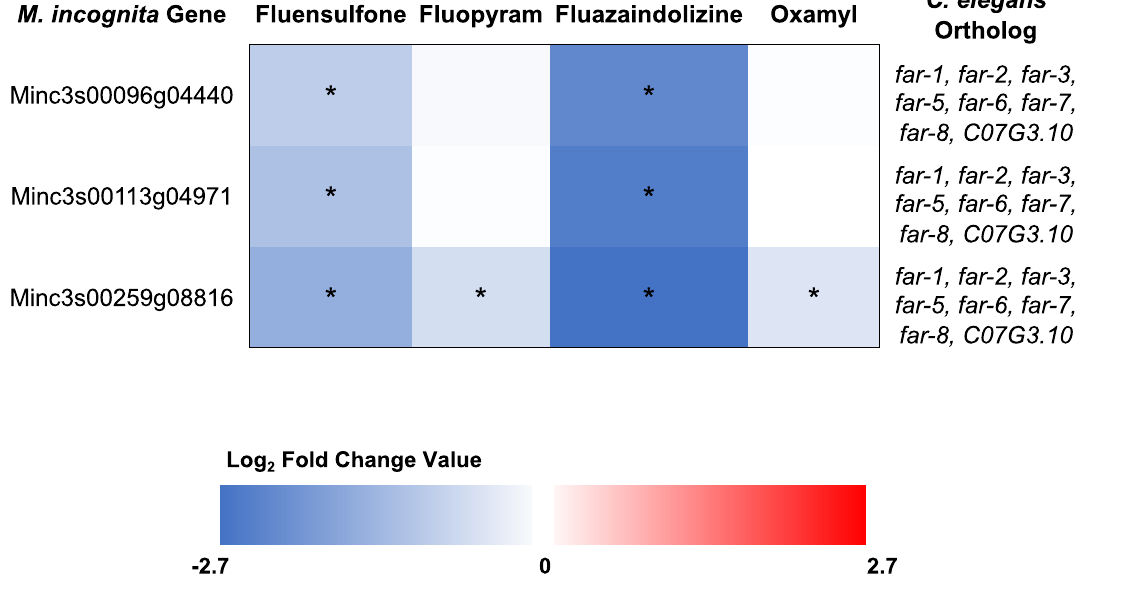
Figure 4. Expression of fatty acid and retinoid binding (FAR) genes. Meloidogyne incognita second-stage juveniles were exposed to fluazaindolizine, fluensulfone, fluopyram, and oxamyl for 24-h and high throughput sequencing used to determine gene expression compared to water control (N = 4 replicates/treatment). The heatmap shows the expression of the 3 genes in M. incognita that contained a Pfam domain for FAR. Expression is in the form of Log 2 Fold Change (Log 2 FC) with red indicating up-regulated expression compared to control, and blue indicating down-regulation. Asterisks throughout the figure represent significantly differentially expressed genes ( p- adjusted value < 0.05). If the gene had orthologs in Caenorhabditis elegans , the gene name is